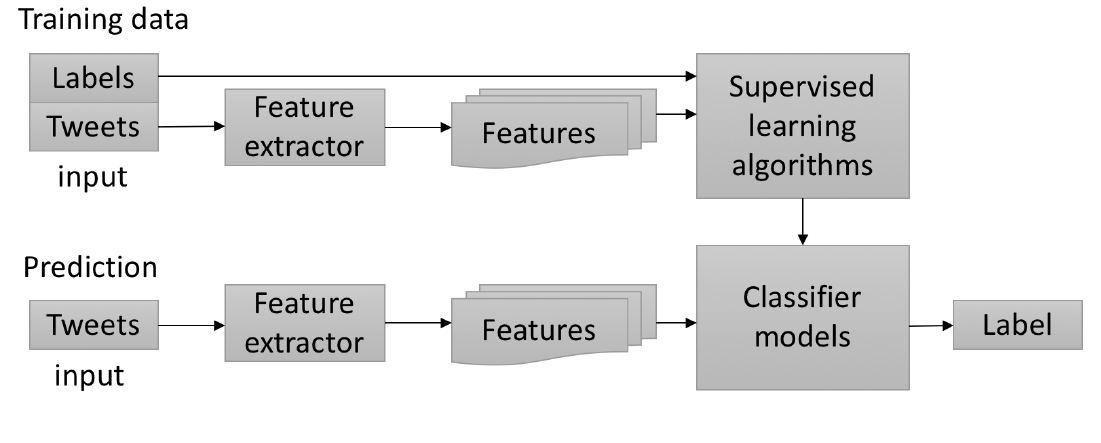
Figure 5. Training and label